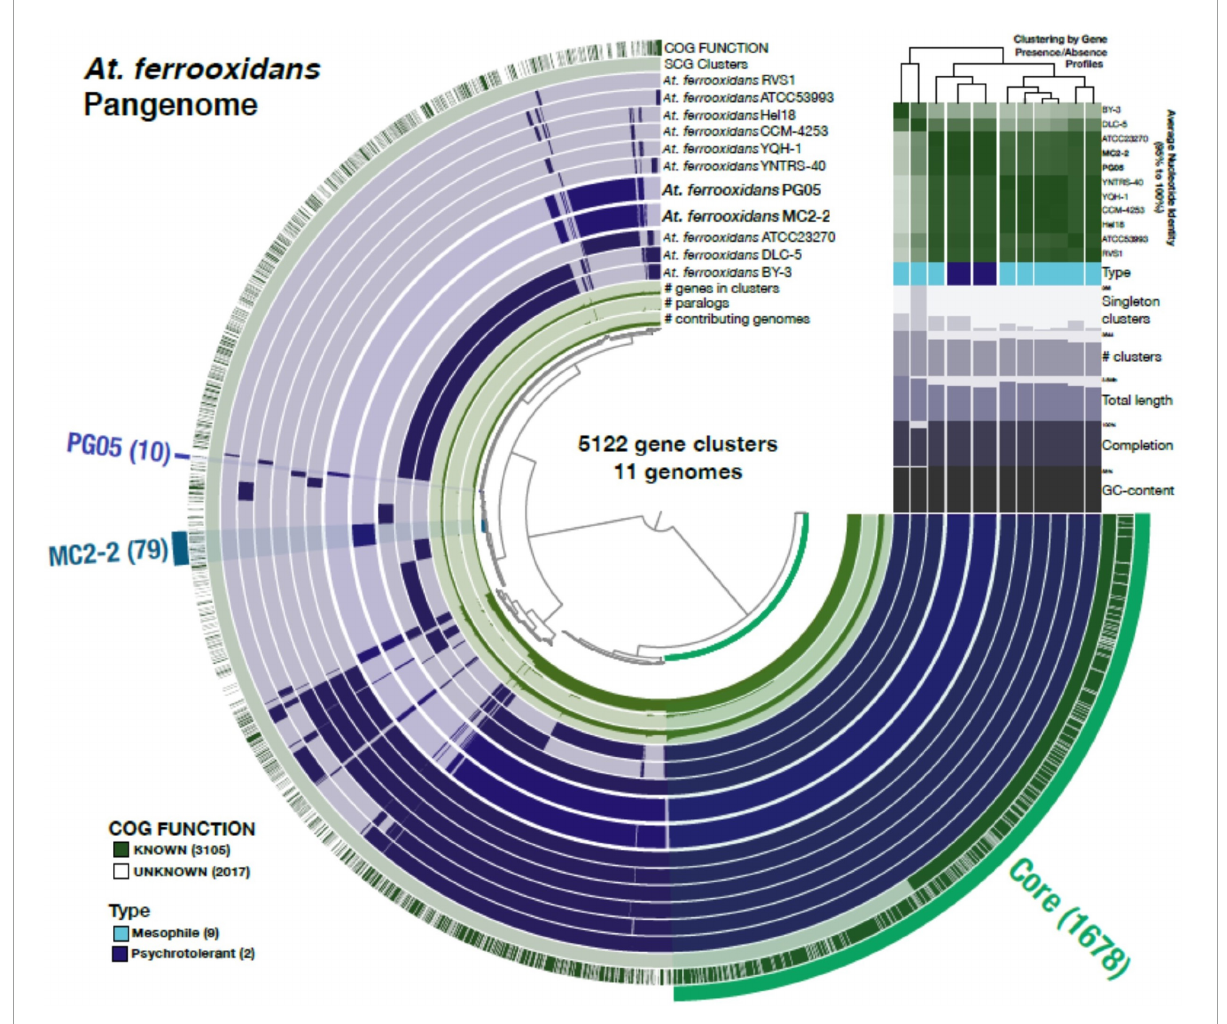
FIGURE6 The At. ferrooxidans pangenome. Each one of the 5,122 gene clusters contains one or more genes contributed by one or more isolate genome. The middle 11 layers are the genomes and the bars indicate the occurrence of a given gene cluster in that strain. The top two outside layers describe (1) the gene clusters in which at least one gene was functionally annotated using COGs and (2) the single copy core-gene clusters across the 11 genomes. The bottom three inside layers show (1) the number of genes in the corresponding cluster; (2) the number of paralogs in the corresponding cluster and (3) the number of genomes on which the corresponding cluster is present. Finally, the outer selections correspond to the Core gene clusters and those exclusively present (“Singletons”) in PG05 and MC2.2. The Average Nucleotide Identity values among the genomes from the high (green) to low (white) similarity are also shown, and the dendrogram on the top represents the hierarchical clustering of genomes based on the occurrence of gene